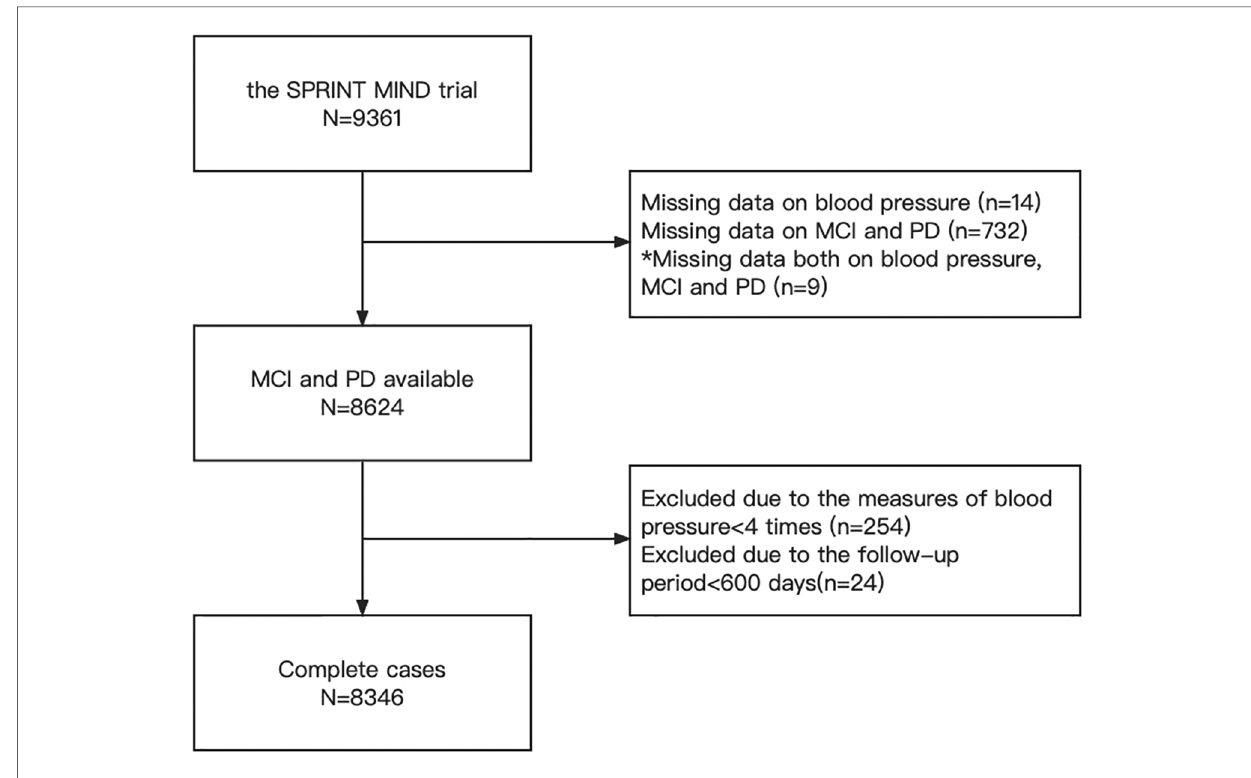
FIGURE 1 Flowchart of participants ’